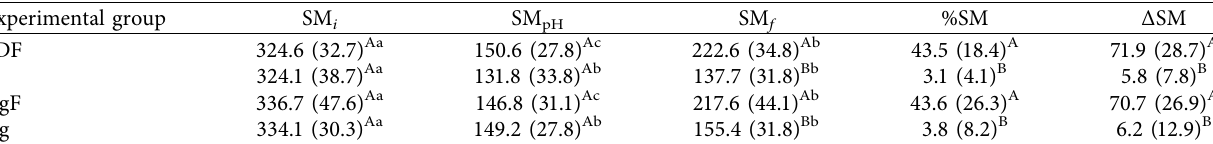
Means followed by different lowercase letters, in line, differ statistically by Tukey’s test; means followed by different uppercase letters, in column, differ statistically by Tukey’s test. The %SH and DSM were compared only between the experimental groups.